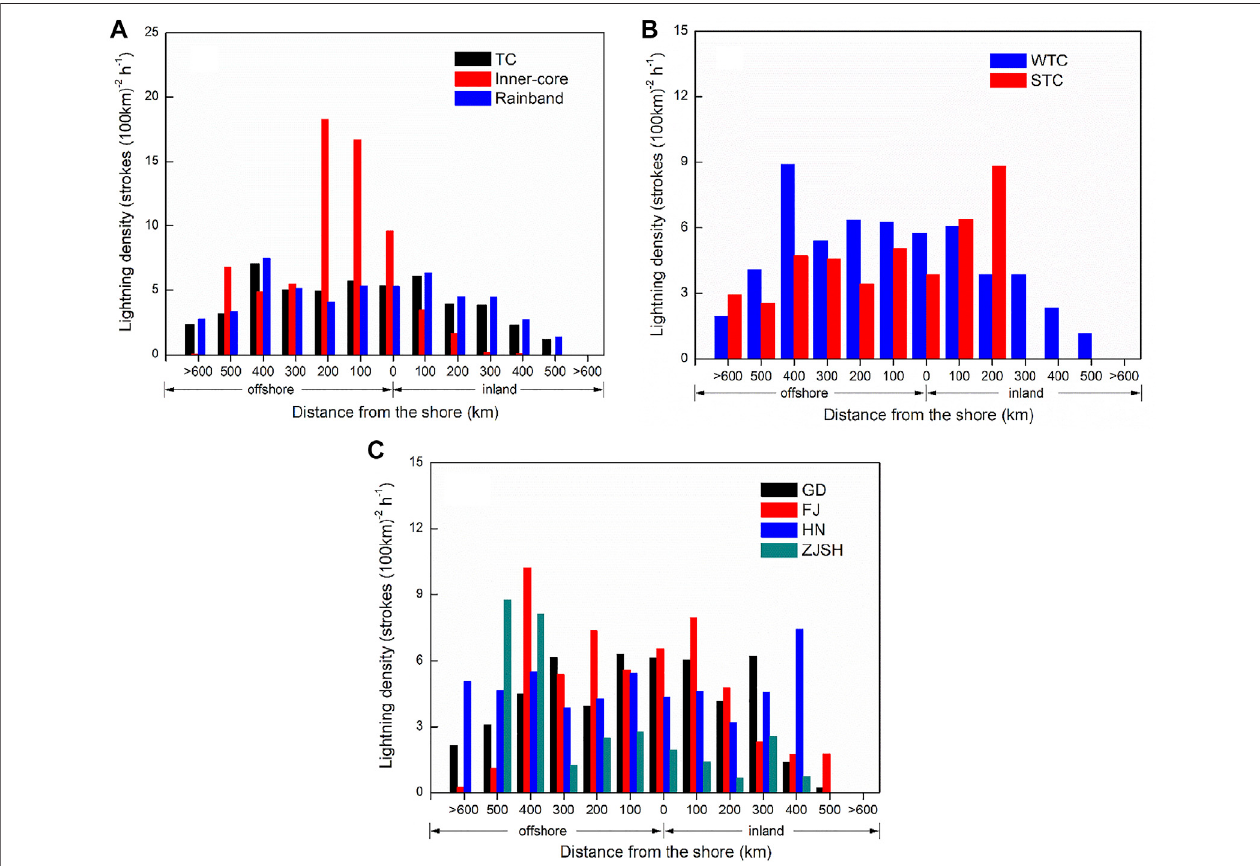
FIGURE6| MeanTClightningdensity(strokes(100 km) − 2 h − 1 )asafunctionofdistancefromtheshorelineforcategoriesof (A) TCregions, (B) TCintensities(weak TC and strong TC), and (C) landing